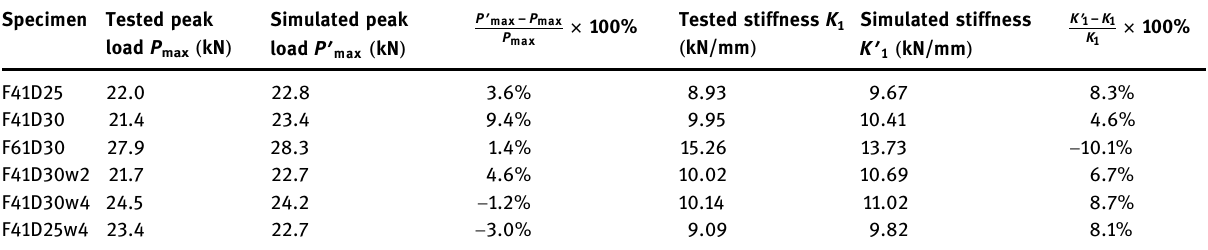
Table 7: Comparison of the initial peak load and stiffness between simulated and experimental results Specimen Tested peak load P max ( kN )